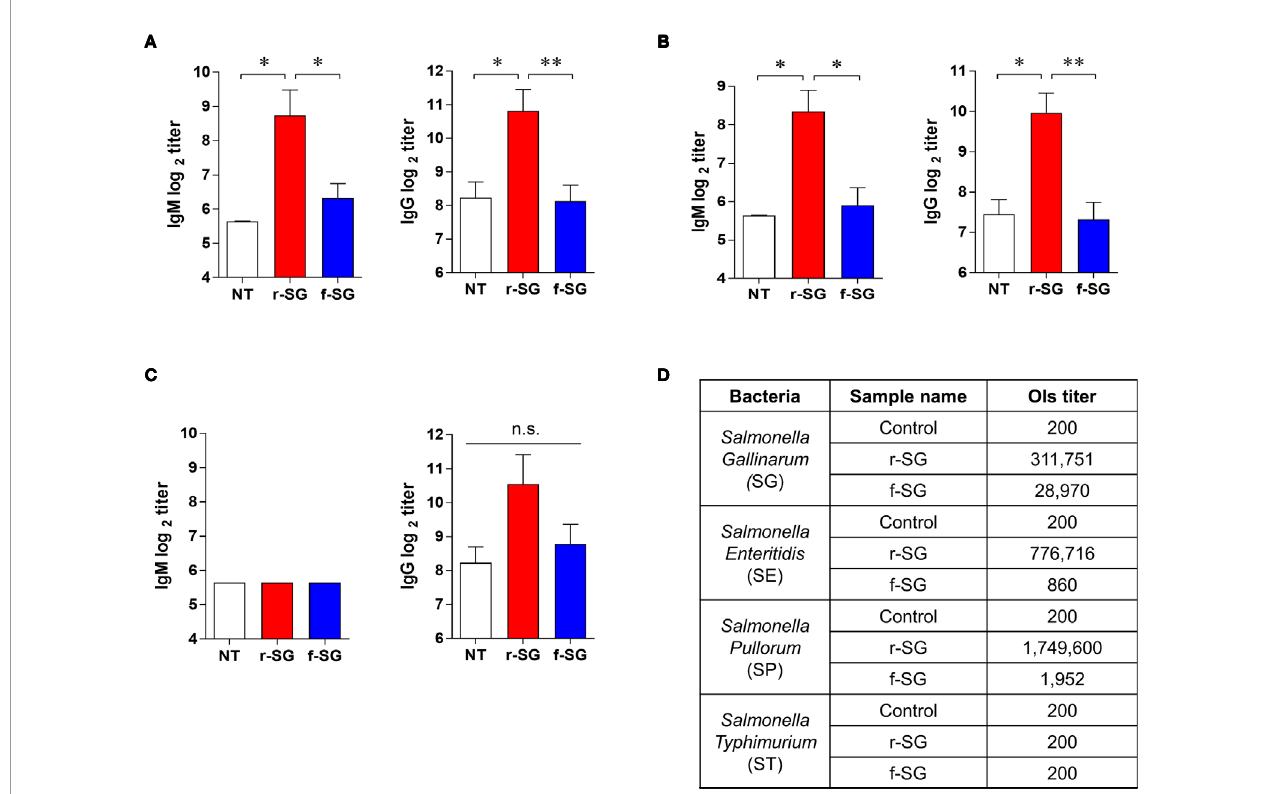
FIGURE 3 | Homogeneous antibody responses by r-SG against Group D Salmonella. Mice (n = 5 per group) were immunized i.p. with 1 × 10 6 CFU of r-SG or f-SG three times at two week intervals and sera were collected two weeks after the last vaccination. (A) SE-speci fi c IgM and IgG, (B) SP-speci fi c IgM and IgG, and (C) ST-speci fi c IgM and IgG in sera were measured by ELISA. (D) Summary of opsonization indices for r-SG and f-SG vaccines against serogroup D (SG, SE, and SP) and serogroup B (ST) Salmonella. *P < 0.05, **P < 0.01, n.s., not signi fi cant, compared to unvaccinated